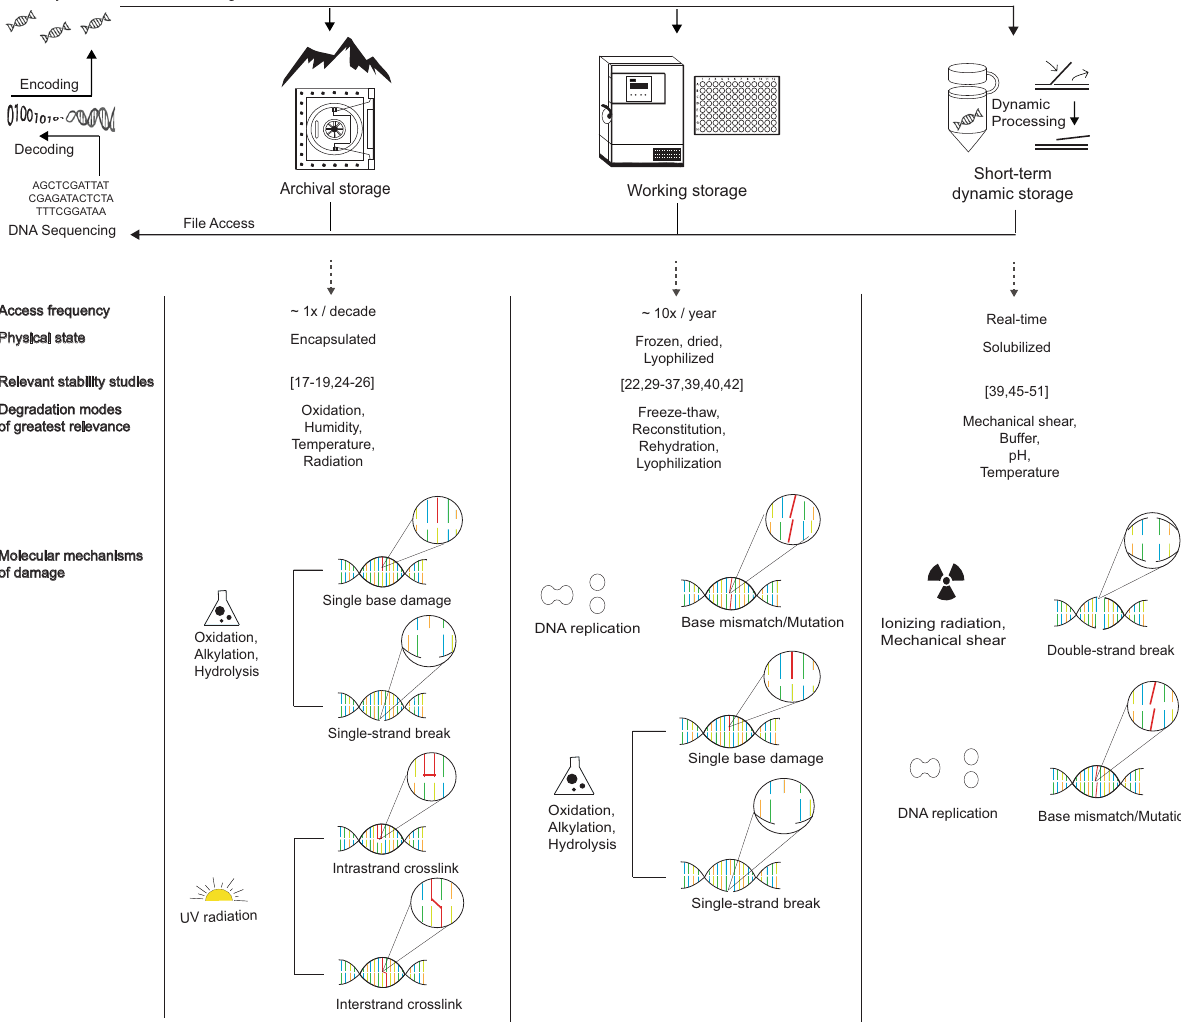
Fig. 1 Categories of DNA storage with distinct longevities, functional characteristics, and degradation modes. (Top) A generic DNA-based system showing distinct types of storage modes. (Middle) Functional and physical characteristics of each storage mode. (Bottom) Molecular mechanisms of damage most relevant to each storage